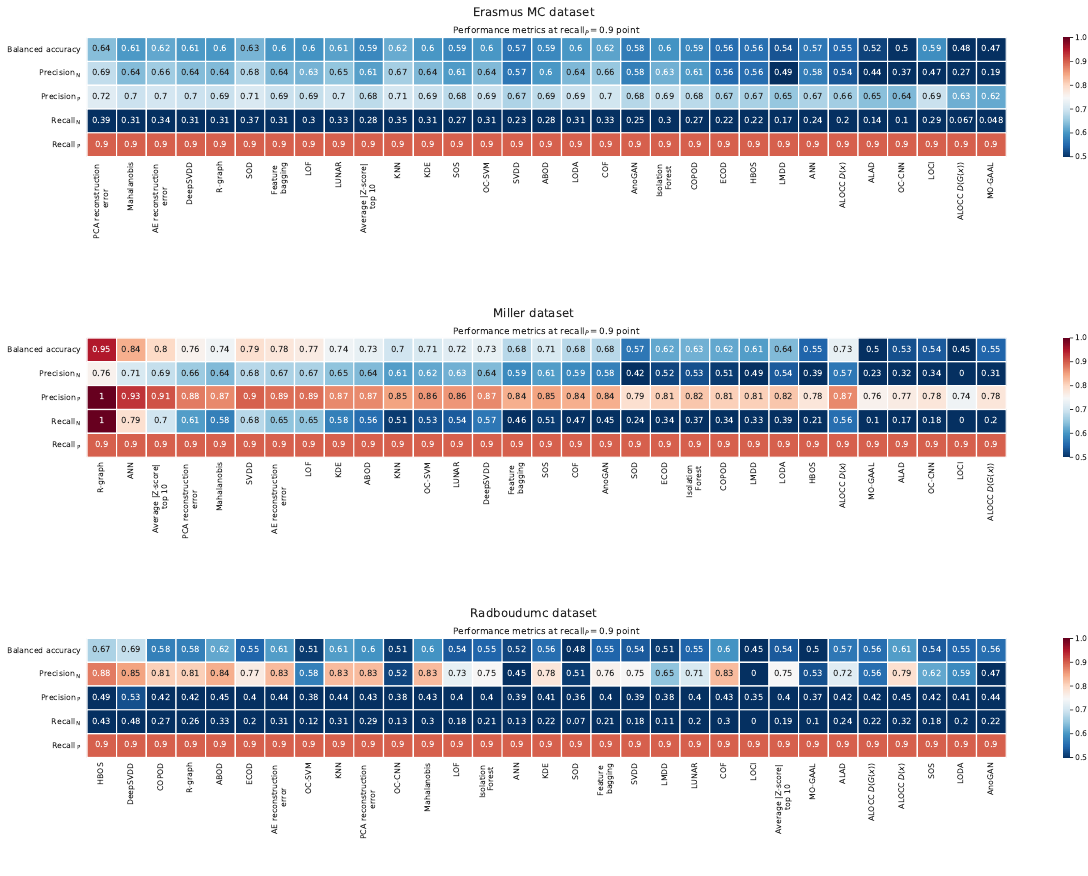
Figure A6. Balanced accuracy, recall, and precision at the point in the ROC curve where recall P = 0.9. All reported values are the average across all (test) cross-validations.